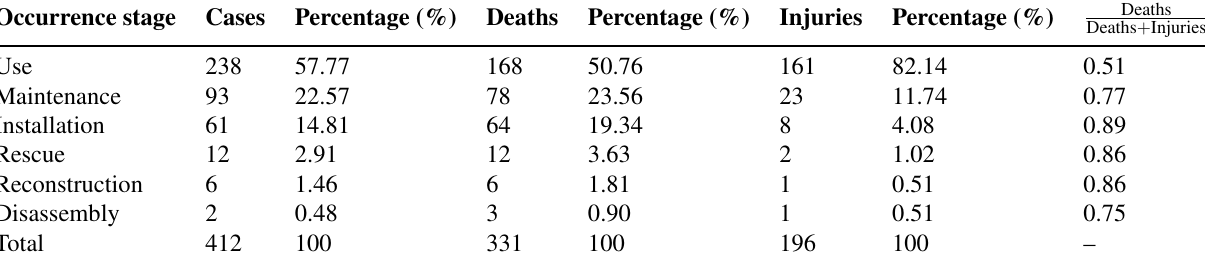
Table 2 Statistics on the occurrence stages of elevator accidents and the number of casualties.